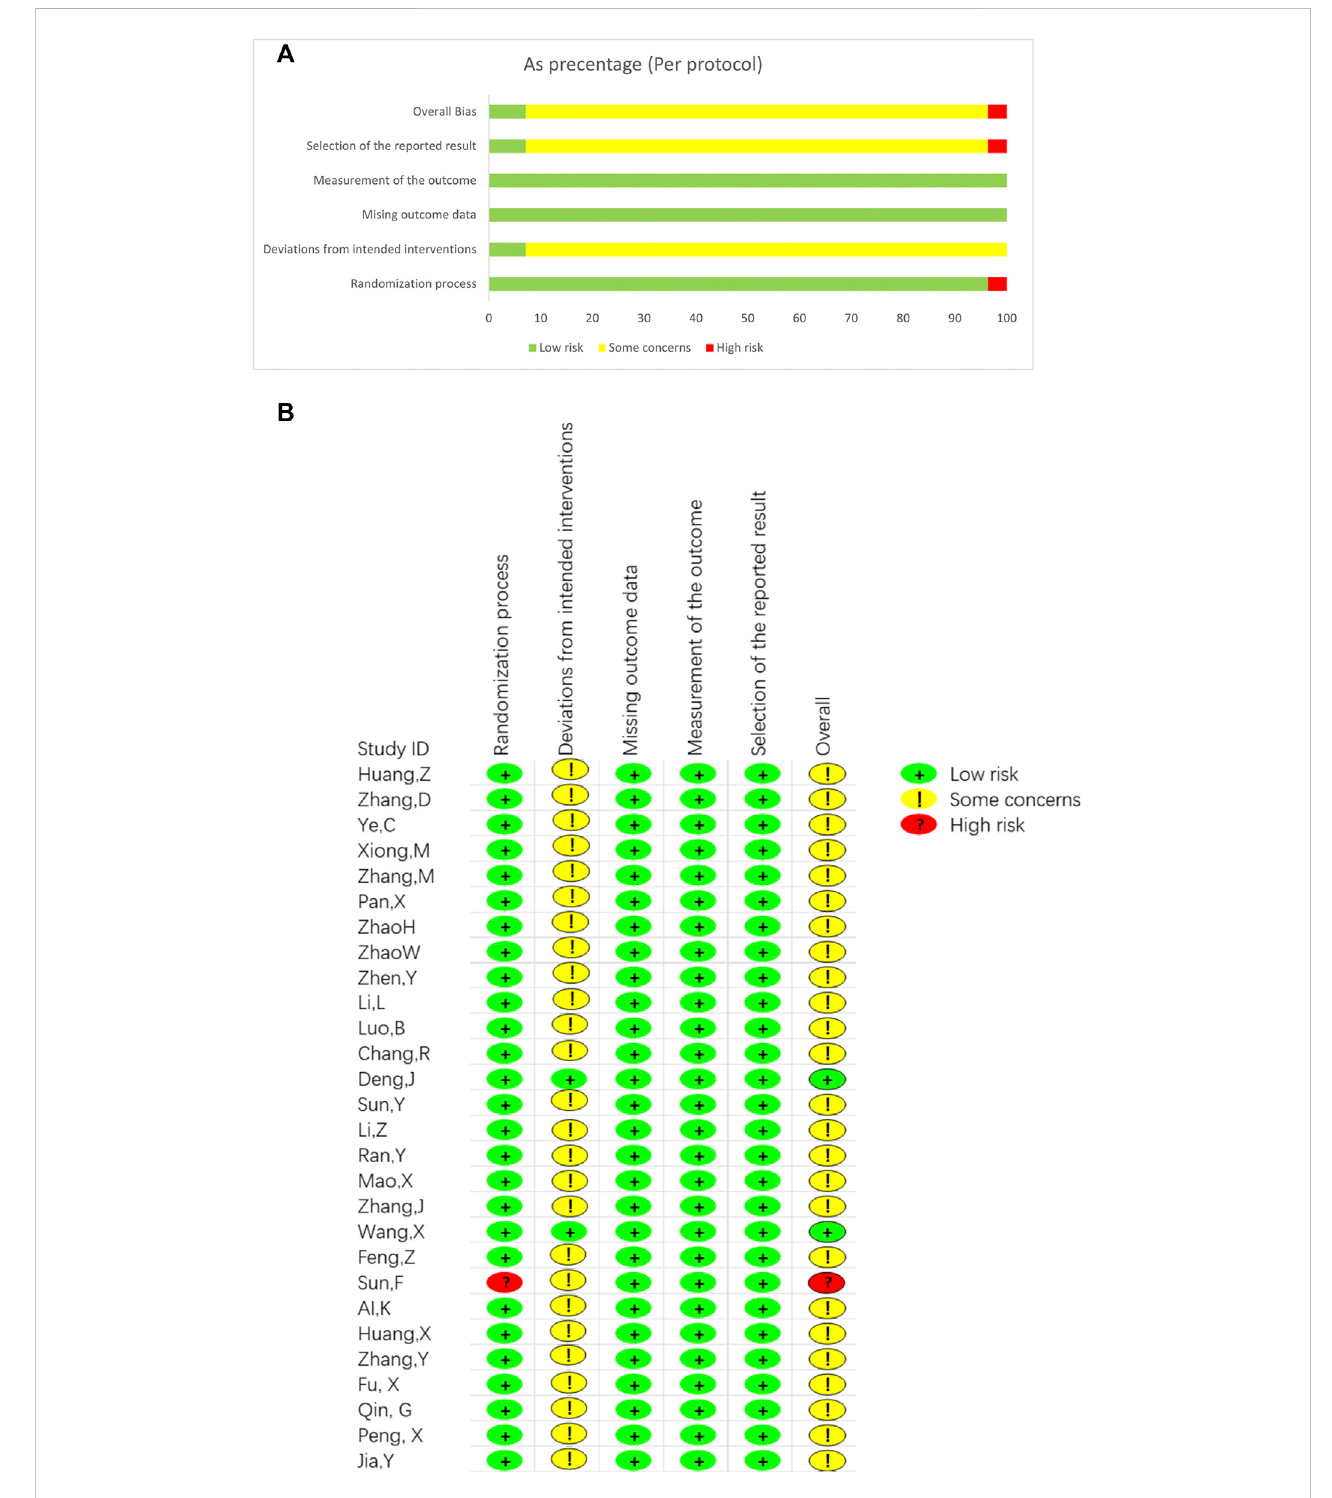
FIGURE 2 Risk of bias summary and diagram. (A) Risk of bias summary. (B) Risk of bias